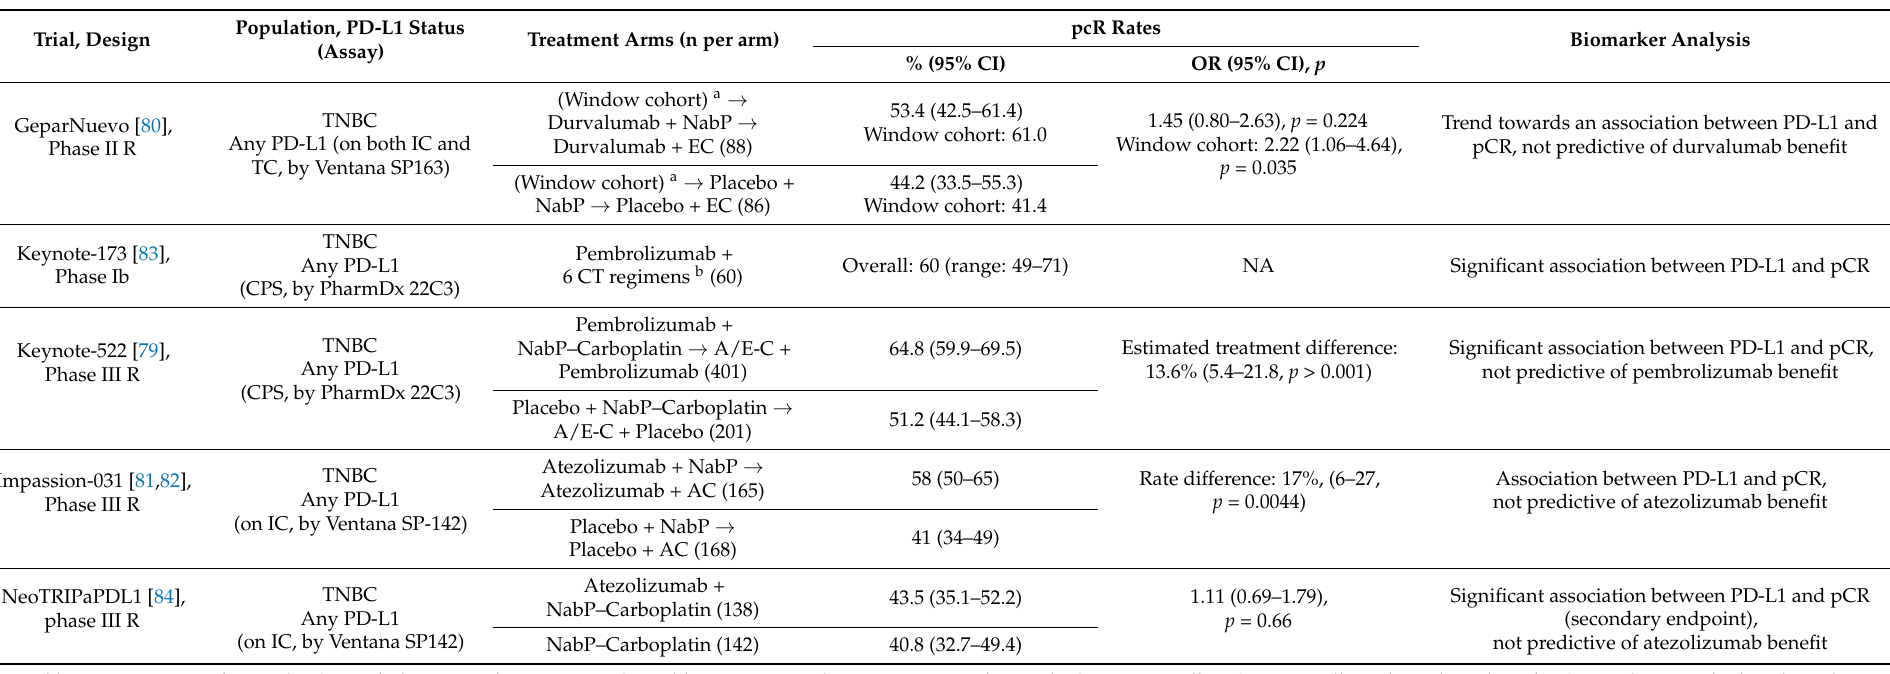
Table 1. Summary of available evidence on PD-L1 evaluation in clinical trials testing immunotherapy in triple-negative breast cancer (TNBC) in the neoadjuvant setting. Trial,